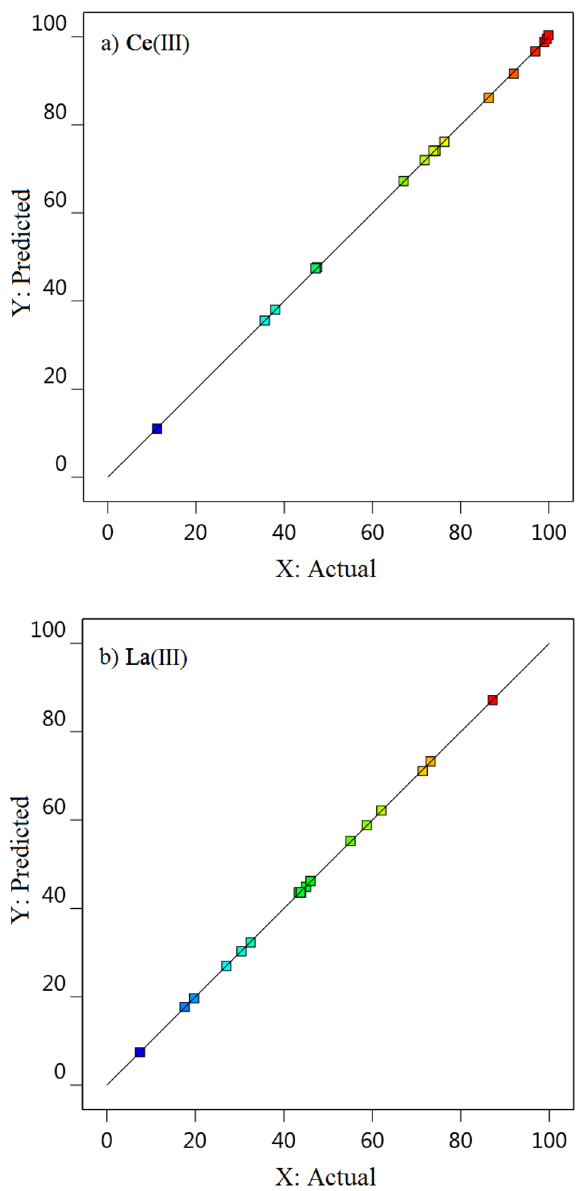
Figure 5. The sketch of calculated data versus experimental amounts of Ce(ΙΙΙ) and La(ΙΙΙ) ions